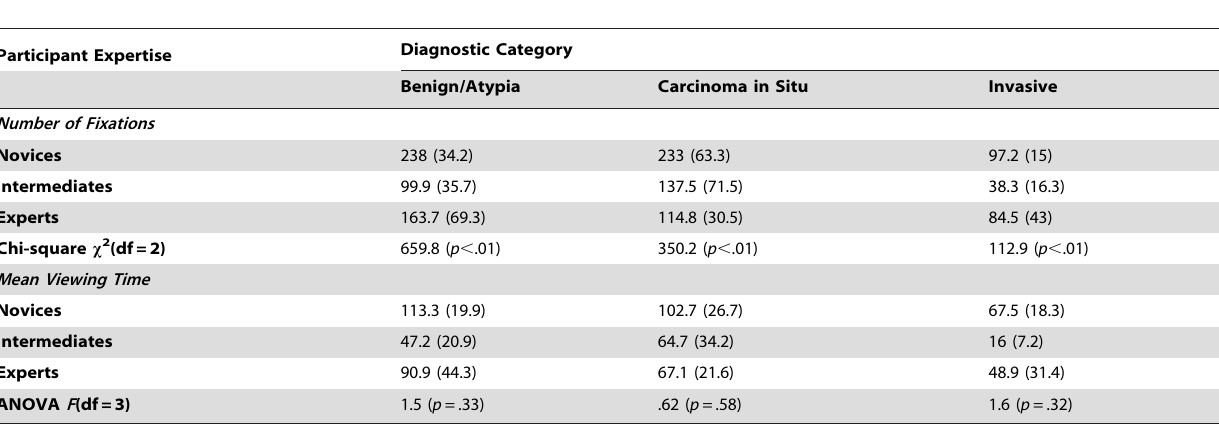
Table 1. Mean (and standard error) number of fixations and viewing time (in seconds) as a function of diagnostic category and expertise